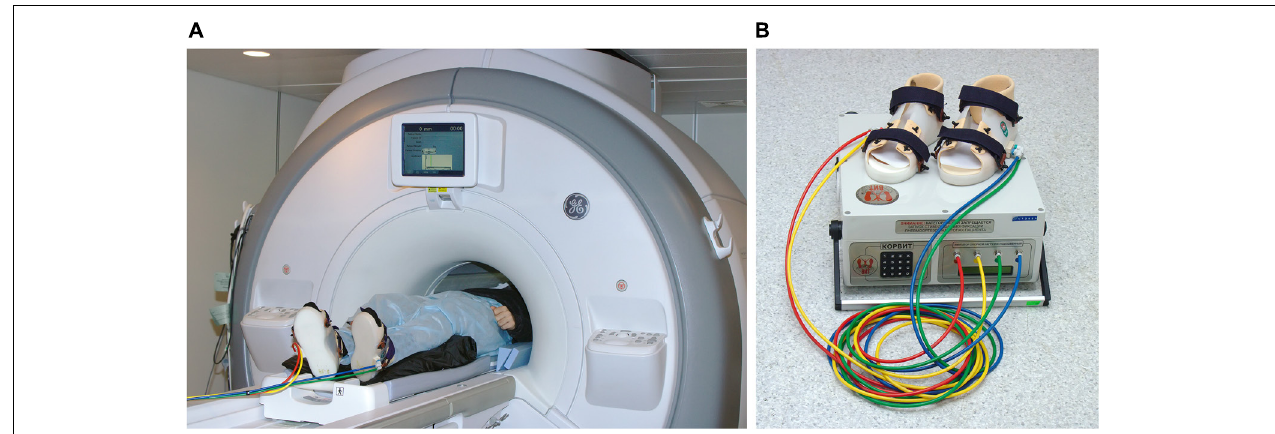
FIGURE 1 | Experimental setup. (A) A participant positioned in the scanner wearing the KORVIT system boots. (B) Components of the KORVIT system.